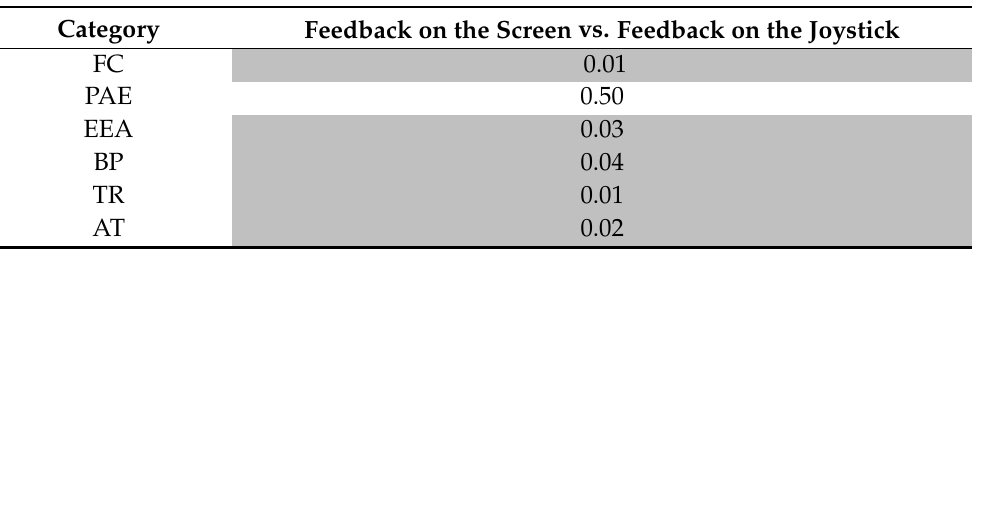
Table 4. p -values obtained from the Mann–Whitney–Wilcoxon test. The highlighted values (in gray) indicate differences with a significance level of